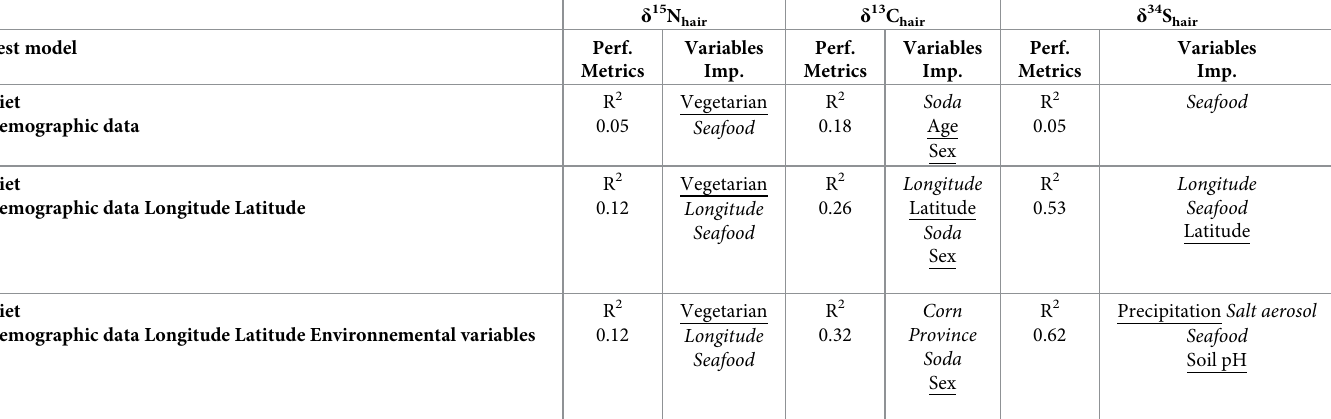
Table 6. Summary of multivariate random forest regression modeling for each isotopic system. Variables are ranked by importance in the regression model. The pre- dictors have either a significant positive (italics) or negative (underline) correlation with isotope data (Pearson correlation; p-value < 0.01). R 2 = Coefficient of